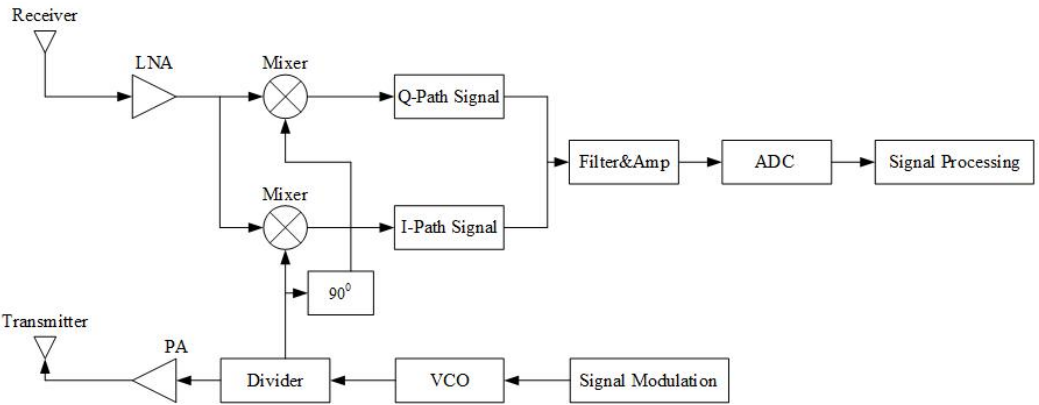
Figure 1. Linear frequency modulated continuous wave (LFMCW) system diagram.